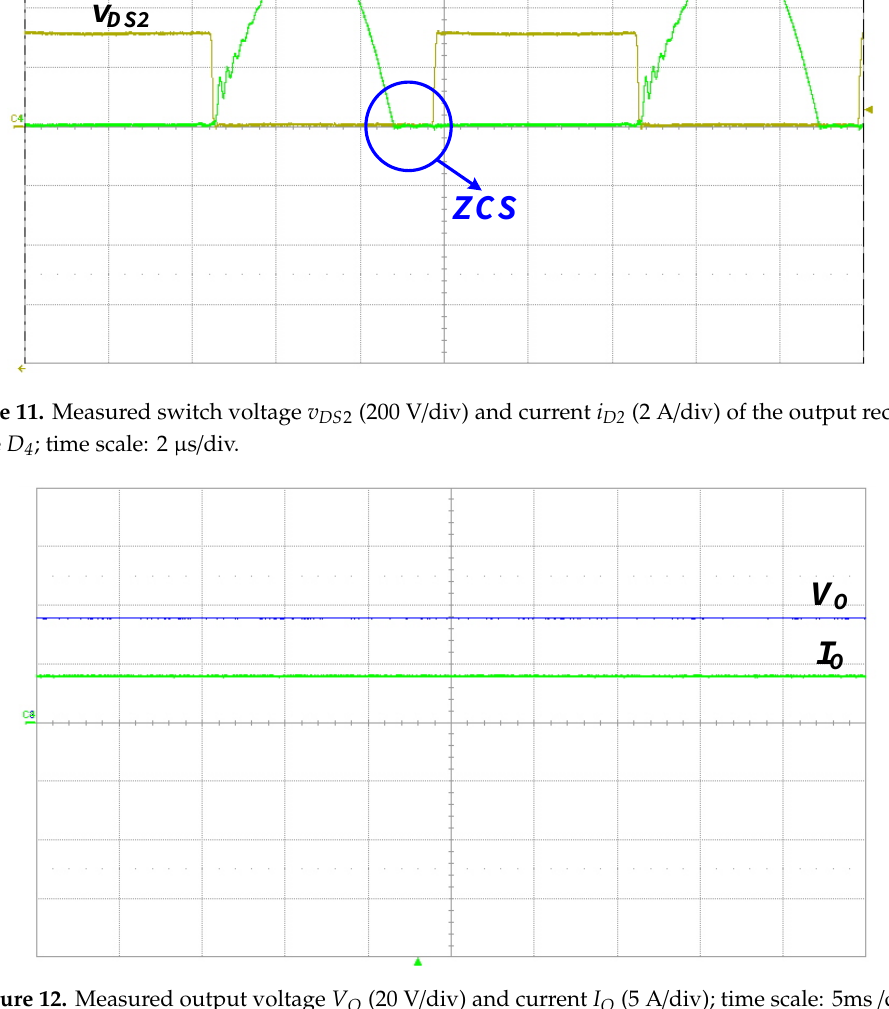
Figure 12. Measured output voltage V O (20 V/div) and current I O (5 A/div); time scale: 5ms /div.